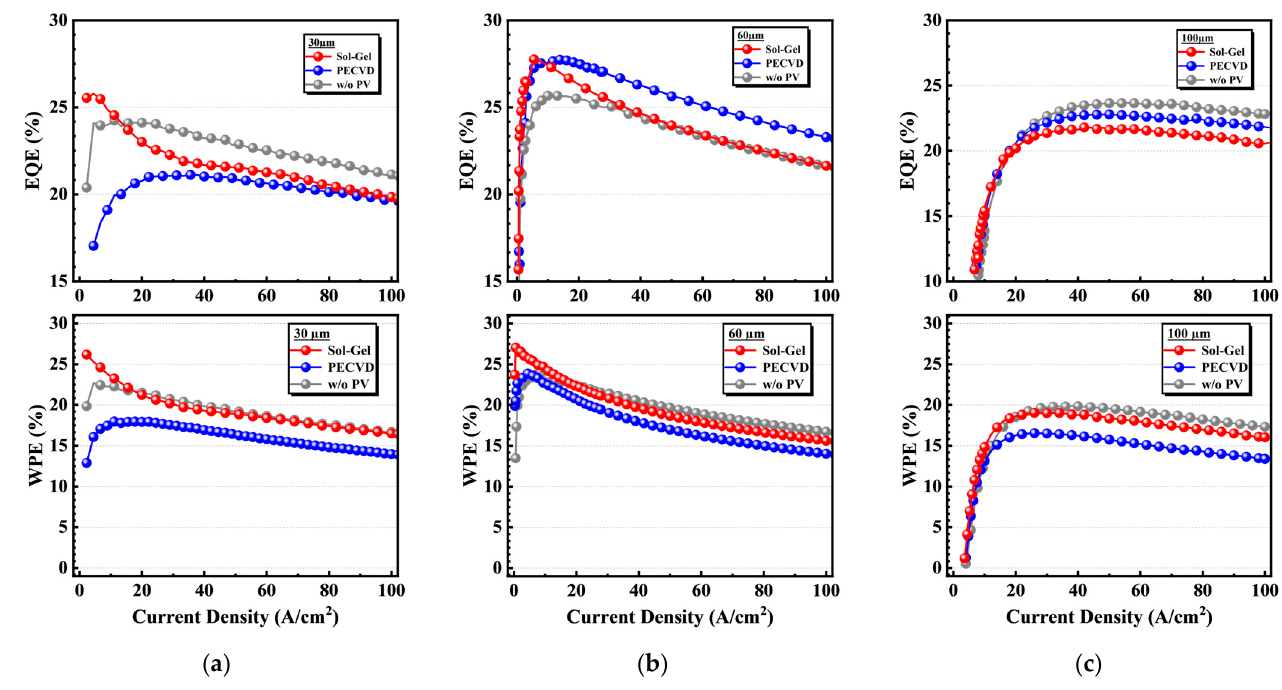
Figure A4. ( a ) Standard deviation and ( b ) coefficient of variation of Micro-LEDs with different pas- sivation and sizes, ( c ) presents the results of our point selection method, which divides the edge (red) and center (blue) regions .